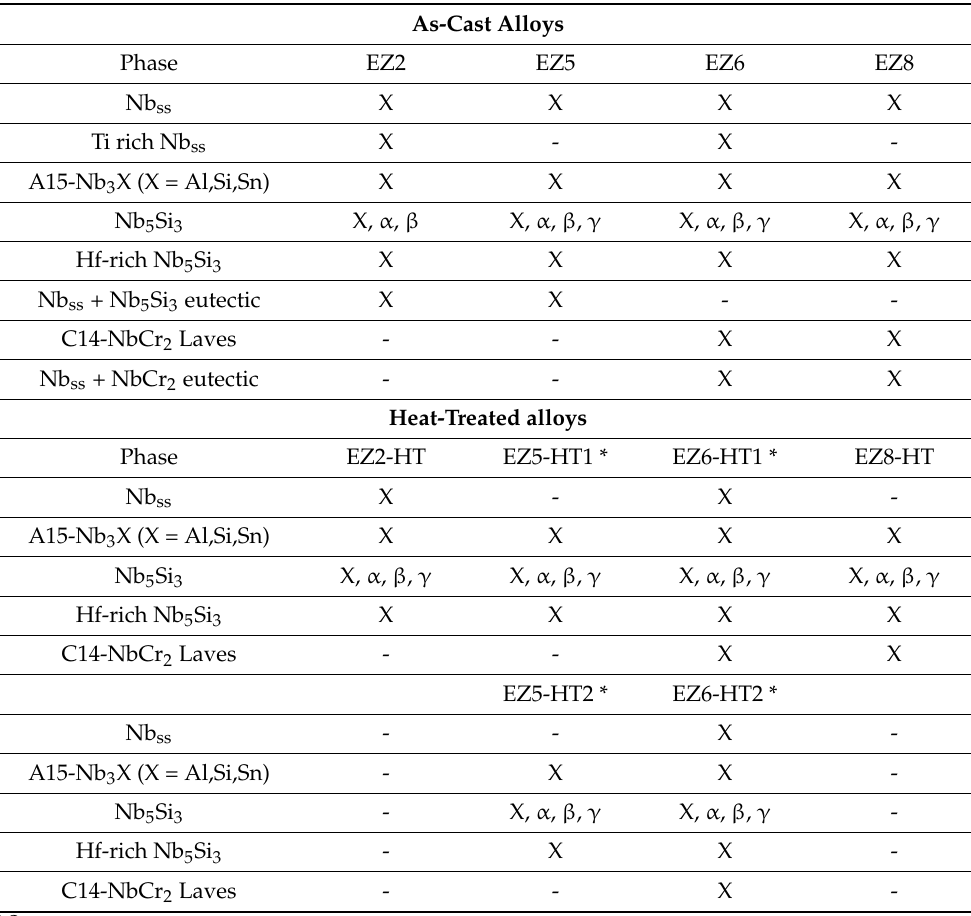
Table 3. Summary of phases in the AC and HT alloys EZ2, EZ5, EZ6, and EZ8. Note that α , β , and γ refer to the structure of Nb 5 Si 3 [38]: α and β , tetragonal Nb 5 Si 3 ; γ , hexagonal Nb 5 Si 3